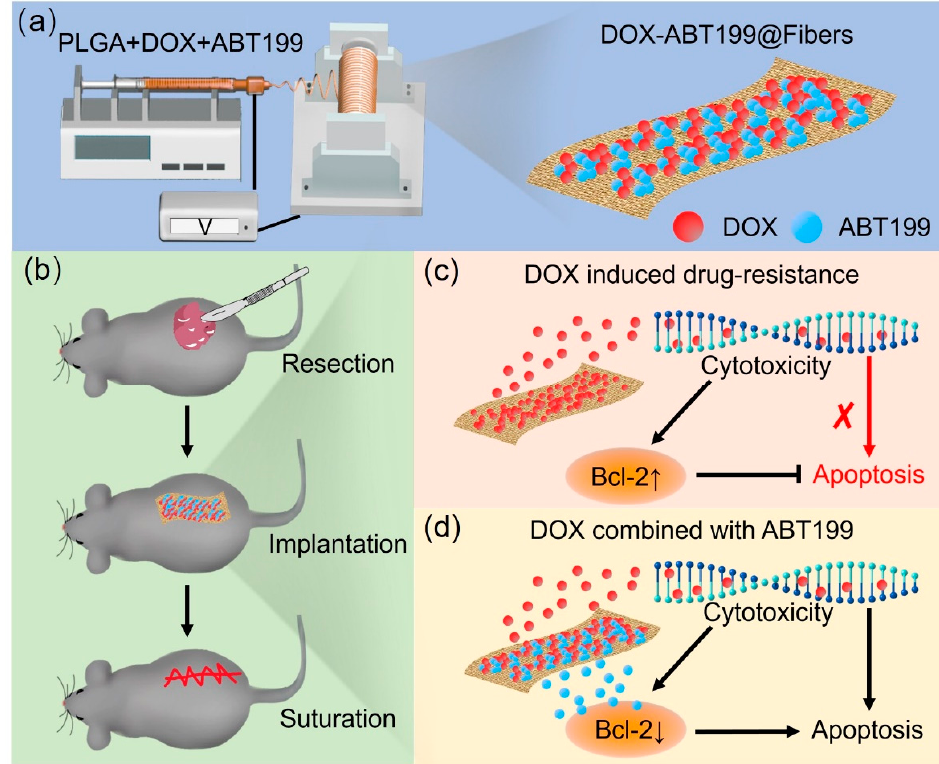
Figure 1. Schematic illustration of ( a ) the fabrication of DOX-ABT199@Fibers, ( b ) the procedure of the inhibition of the tumor recurrence, and ( c , d ) the local delivery of drugs after tumor resection and the synergistic effect of the sustainedly released DOX and the Bcl-2 inhibitor ABT199 (the red cross symbol means that the process was weakened).